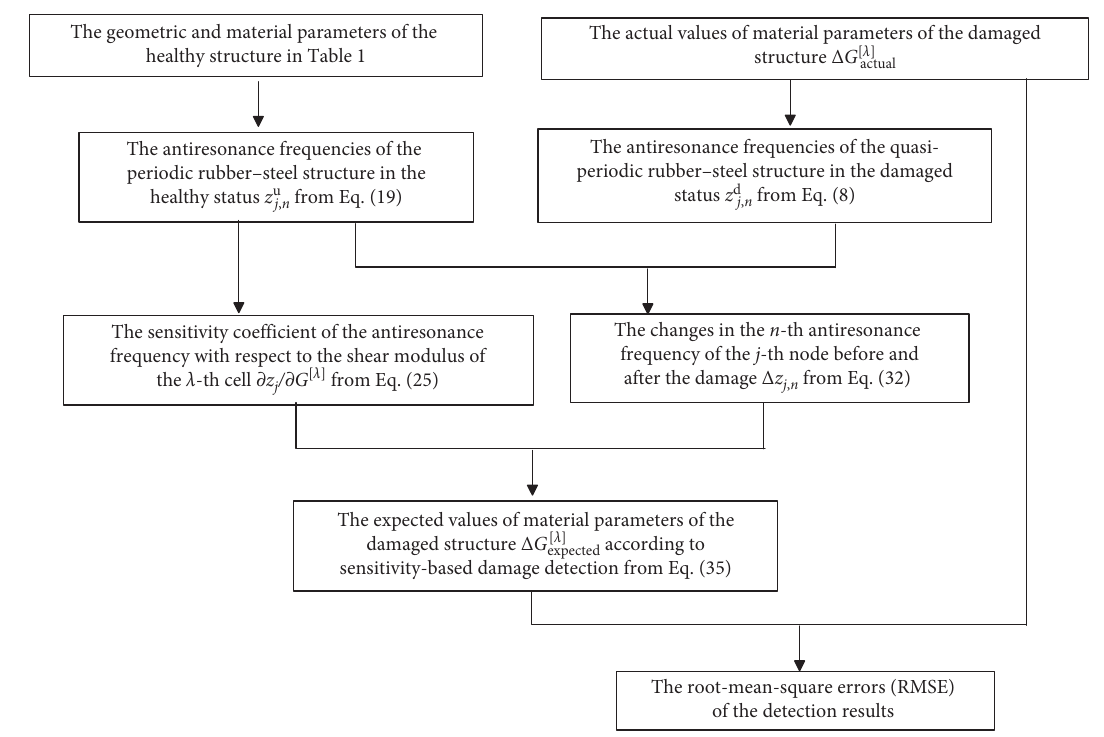
Figure 4: The procedure of damage detection in laminated rubber bearing. Table 4: Selection of driving